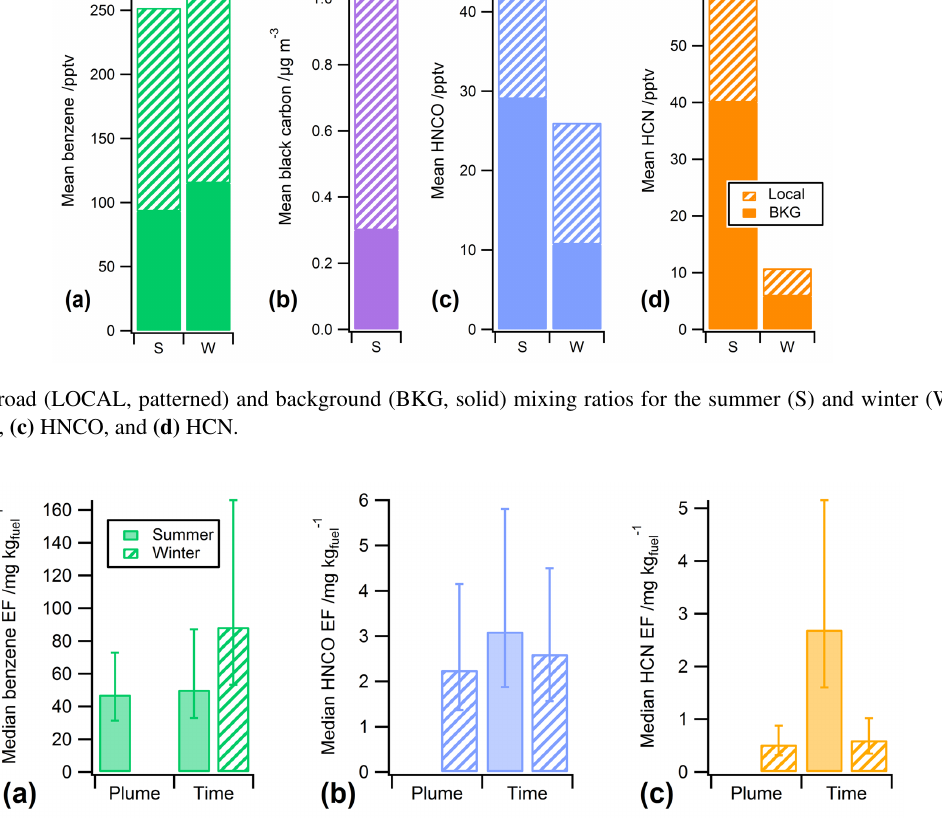
Figure 3. Median emission factors for (a) benzene, (b) HNCO, and (c) HCN calculated using the SPP plume-based approach (Plume) or the time-based approach with an integration period of 120s (Time). The error bars show the interquartile range. Values obtained from the summer campaign (solid bars) and winter campaign (patterned